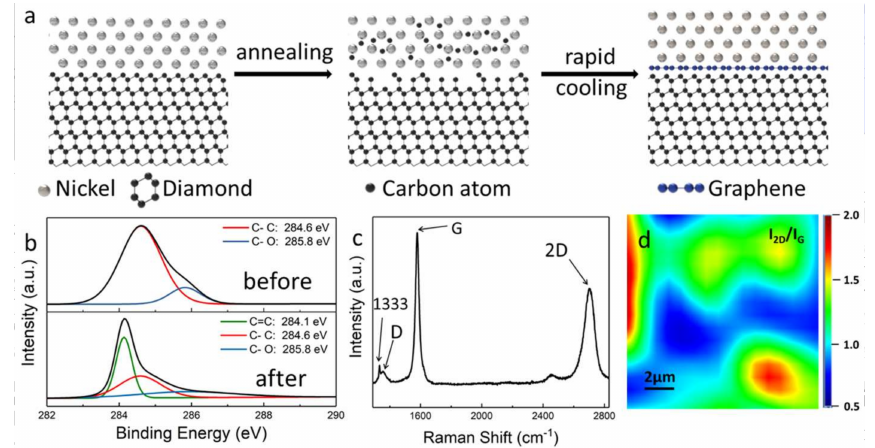
Figure 1. ( a ) Schematic illustration of the conversion process of the graphene–diamond hybrid through catalytic thermal treatment. ( b ) XPS C1s spectrum of pristine HPHT diamond before and after sp 3 -to-sp 2 conversion. ( c ) A typical Raman spectrum and ( d ) Raman mapping of graphene films formed on the diamond surface.